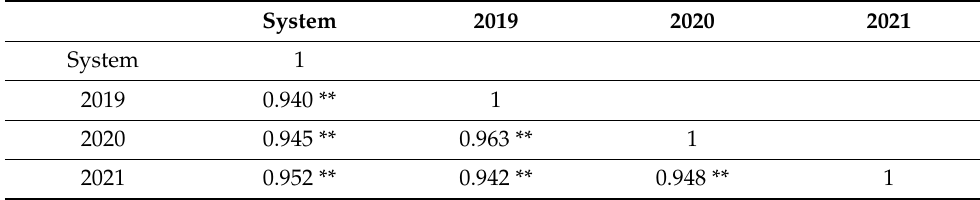
Table 7. Spearman’s rank correlation test results for rankings in three